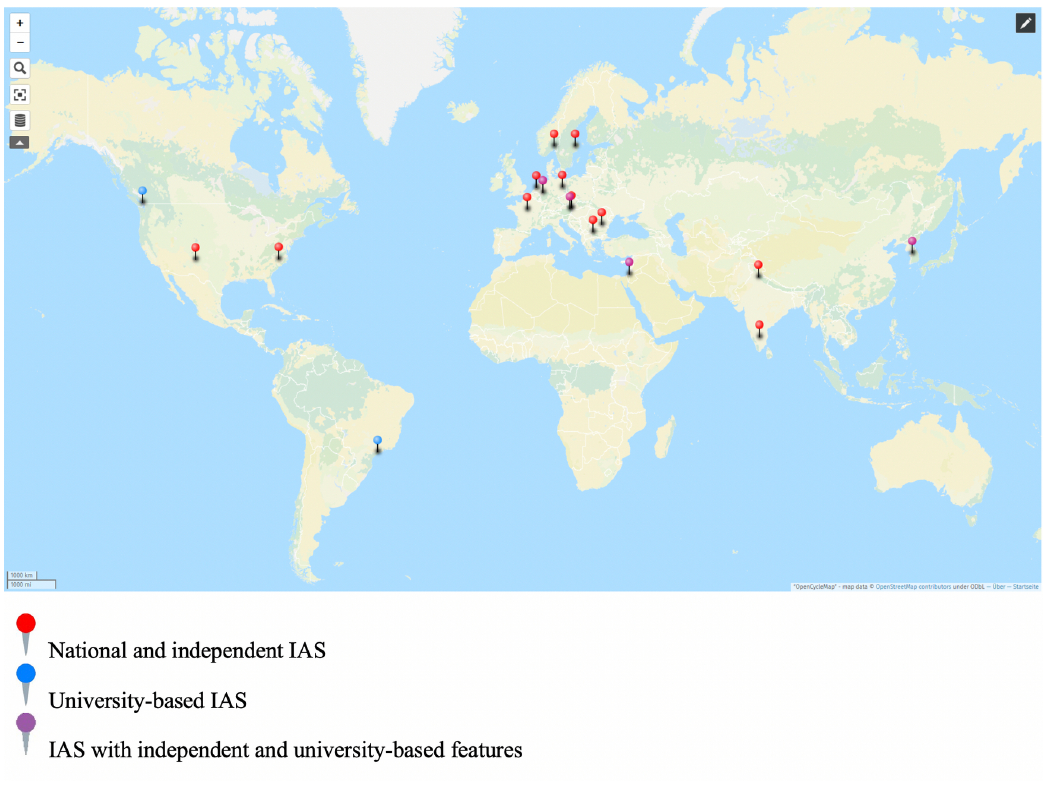
Fig. 2. Generation of the National and independent IAS